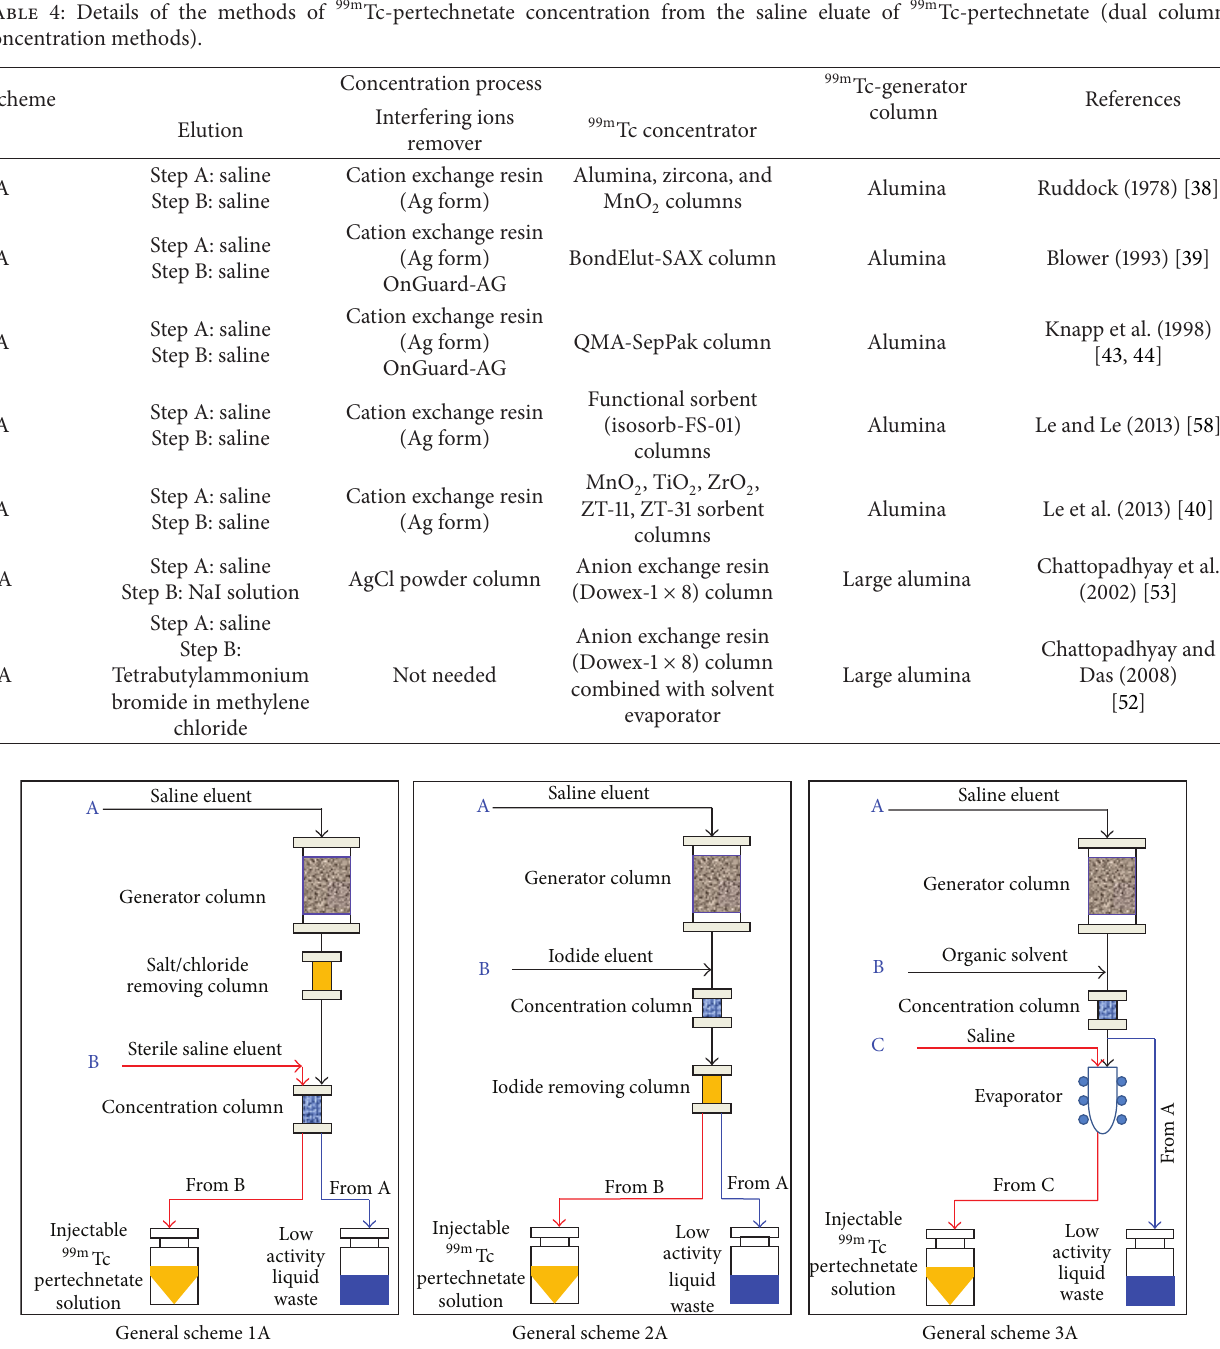
Figure 19: Group 1 of concentration methods: 99 m Tc-pertechnetate concentration from the saline eluate of the 99 m Tc generator.